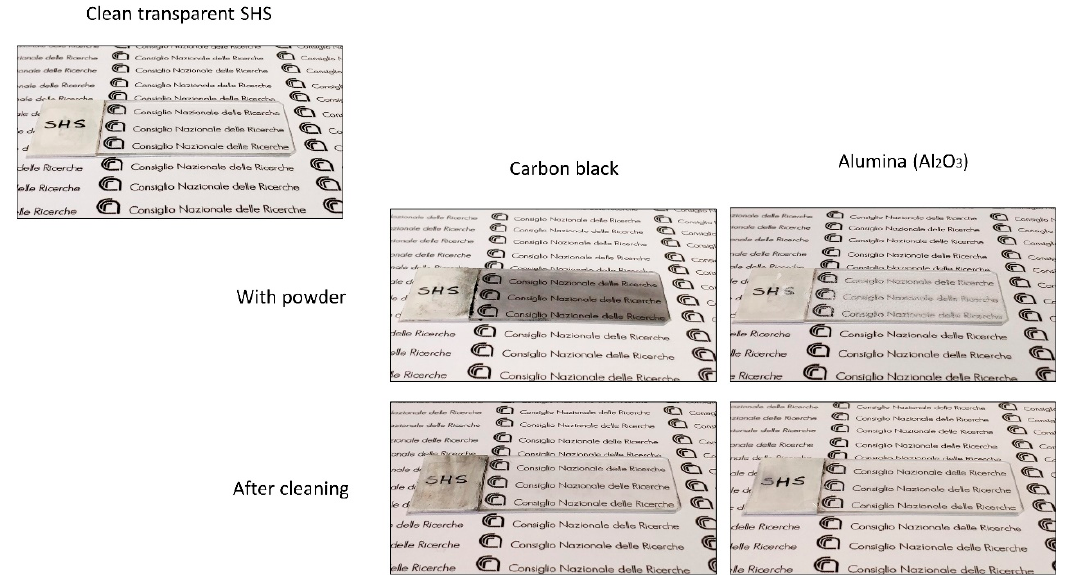
Figure 9. Self-cleaning effect on SH coating. On the right the clean SH coating, on the left the coating after dirtying with carbon black and alumina and below after cleaning with water.